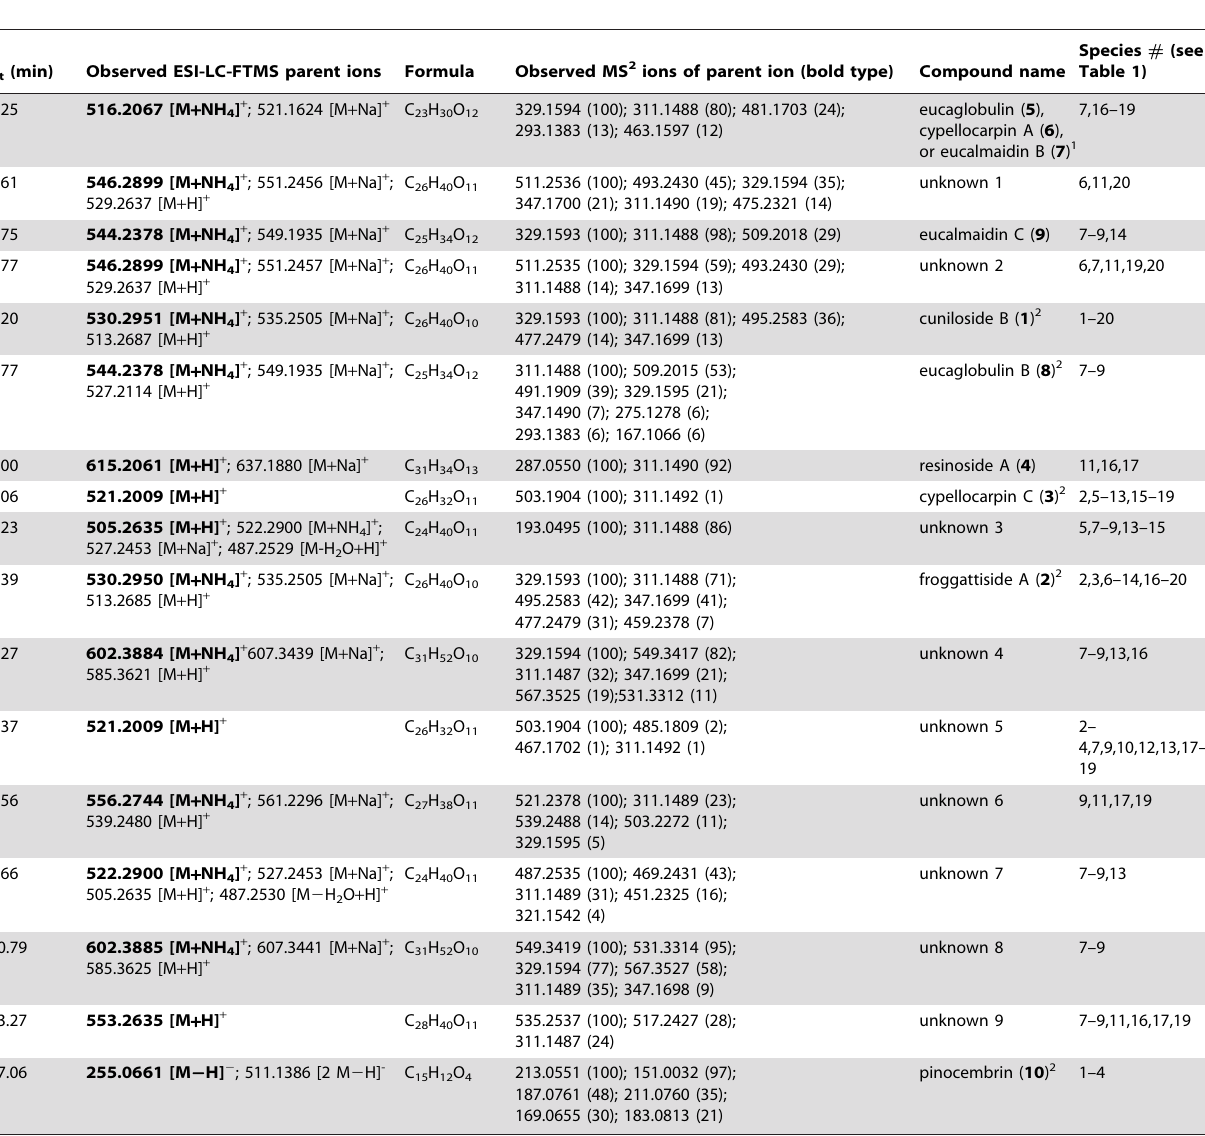
Table 2. Oleuropeyl glucose esters and a flavanone found in secretory cavity extracts of Eucalyptus species and Melaleuca armillaris